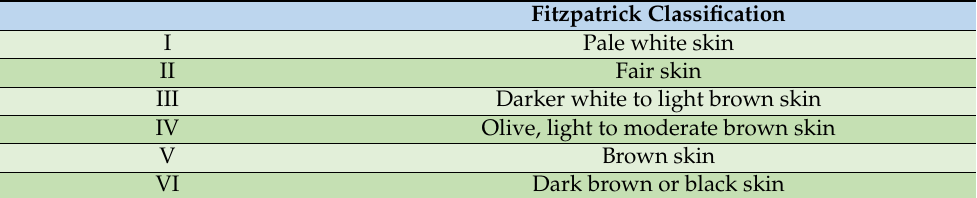
Table 1. Fitzpatrick Skin phototype